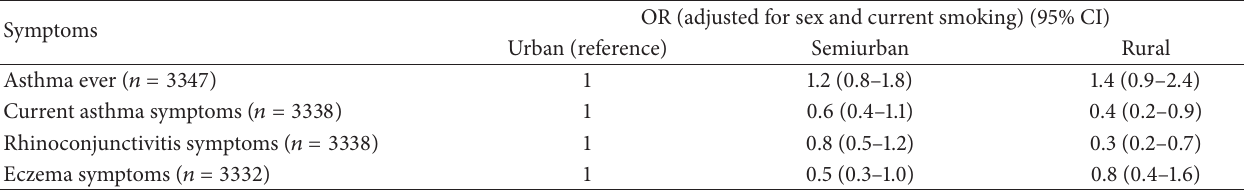
Table 2: Association between residential sector and asthma and associated symptoms stratified by residential sector in the central south of